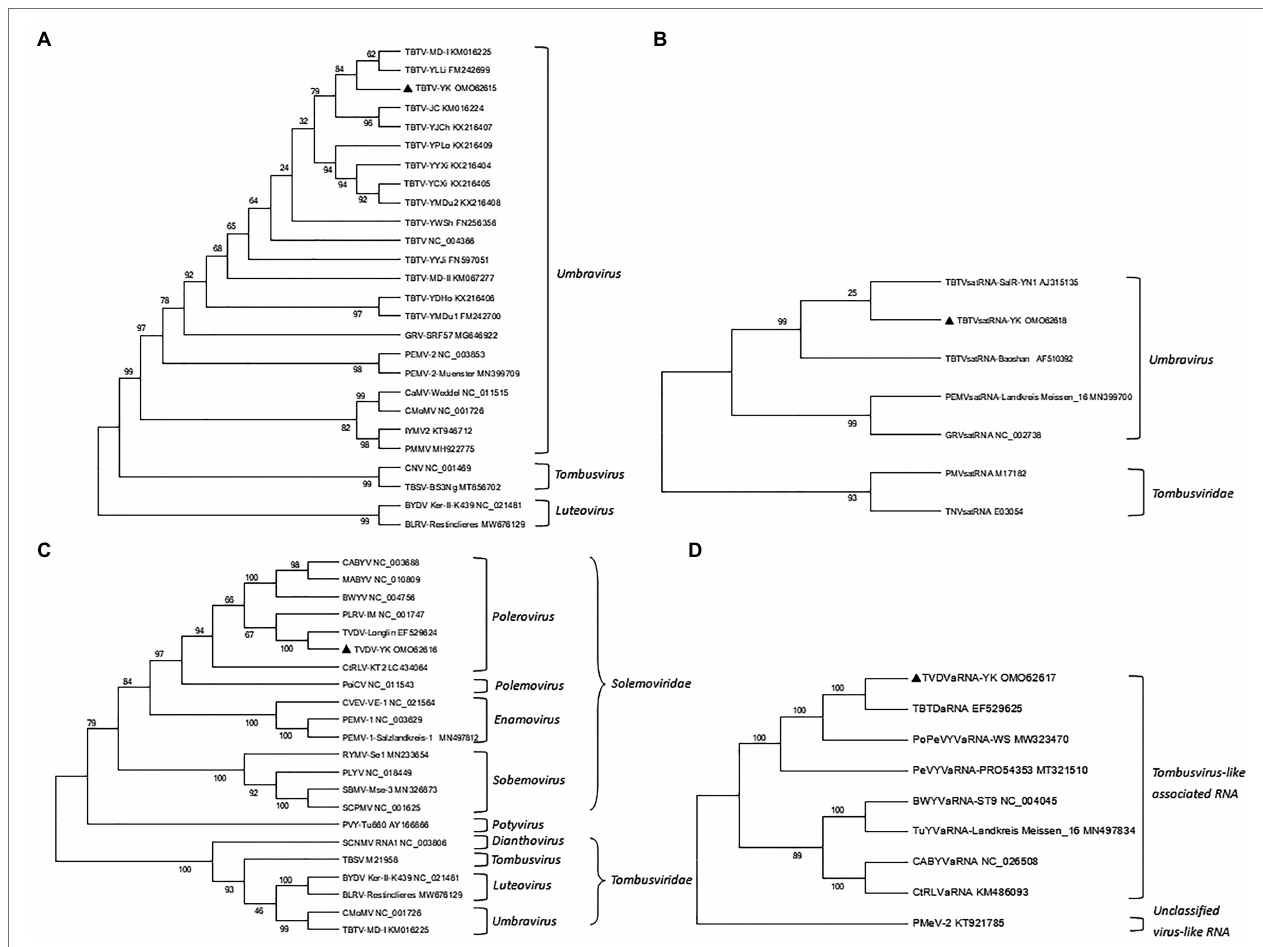
FIGURE 2 | Neighbor-joining phylogenetic trees constructed using the complete nucleotide (nt) sequences of TBTV-YK, TBTVsatRNA-YK, TVDV-YK, TVDVaRNA- YK, and other related viruses. (A) A phylogenetic tree constructed using the nt sequences of TBTV-YK and other viruses in the genus Umbravirus , Tombusvirus , and Luteovirus . (B) A phylogenetic tree constructed using the nt sequences of TBTVsatRNA-YK and other satellite RNAs in the genus Umbravirus . (C) A phylogenetic tree constructed using the nt sequences of TVDV-YK and other viruses in the genus Polemovirus , Polerovirus , Sobemovirus , and Enamovirus in the family Solemoviridae or in the family Tombusviridae . (D) A phylogenetic tree constructed using the nt sequences of TVDVaRNA-YK and other Tombusvirus-like associated